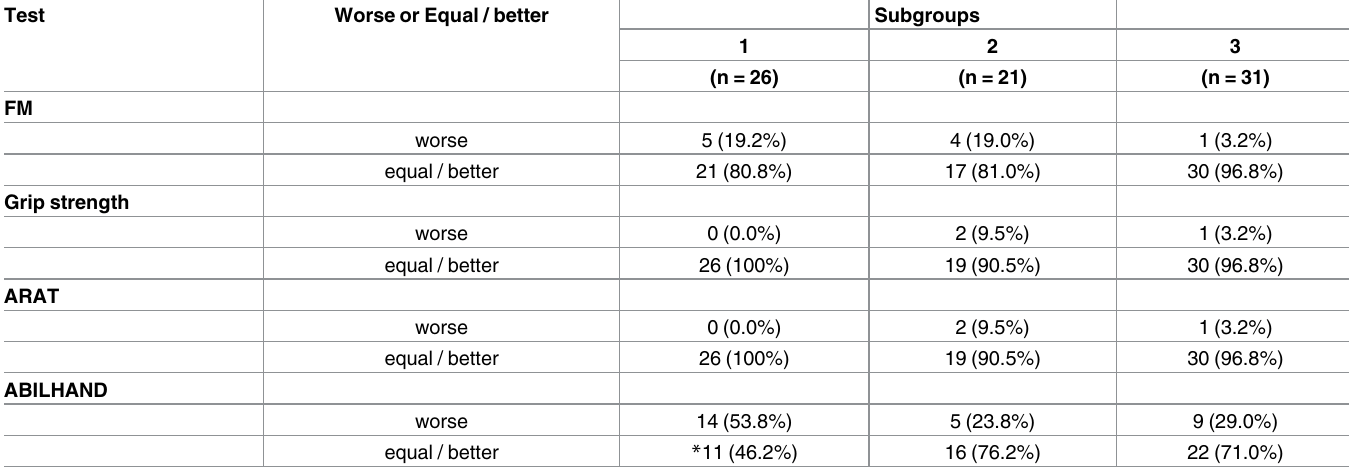
Table 2. Number(and %) of patients per subgroup whose arm-hand capacityand/or performance either deteriorated (more than 5% relative to clin- ical discharge performance), or remained equal or improved during the post-rehabilitation phase. Test